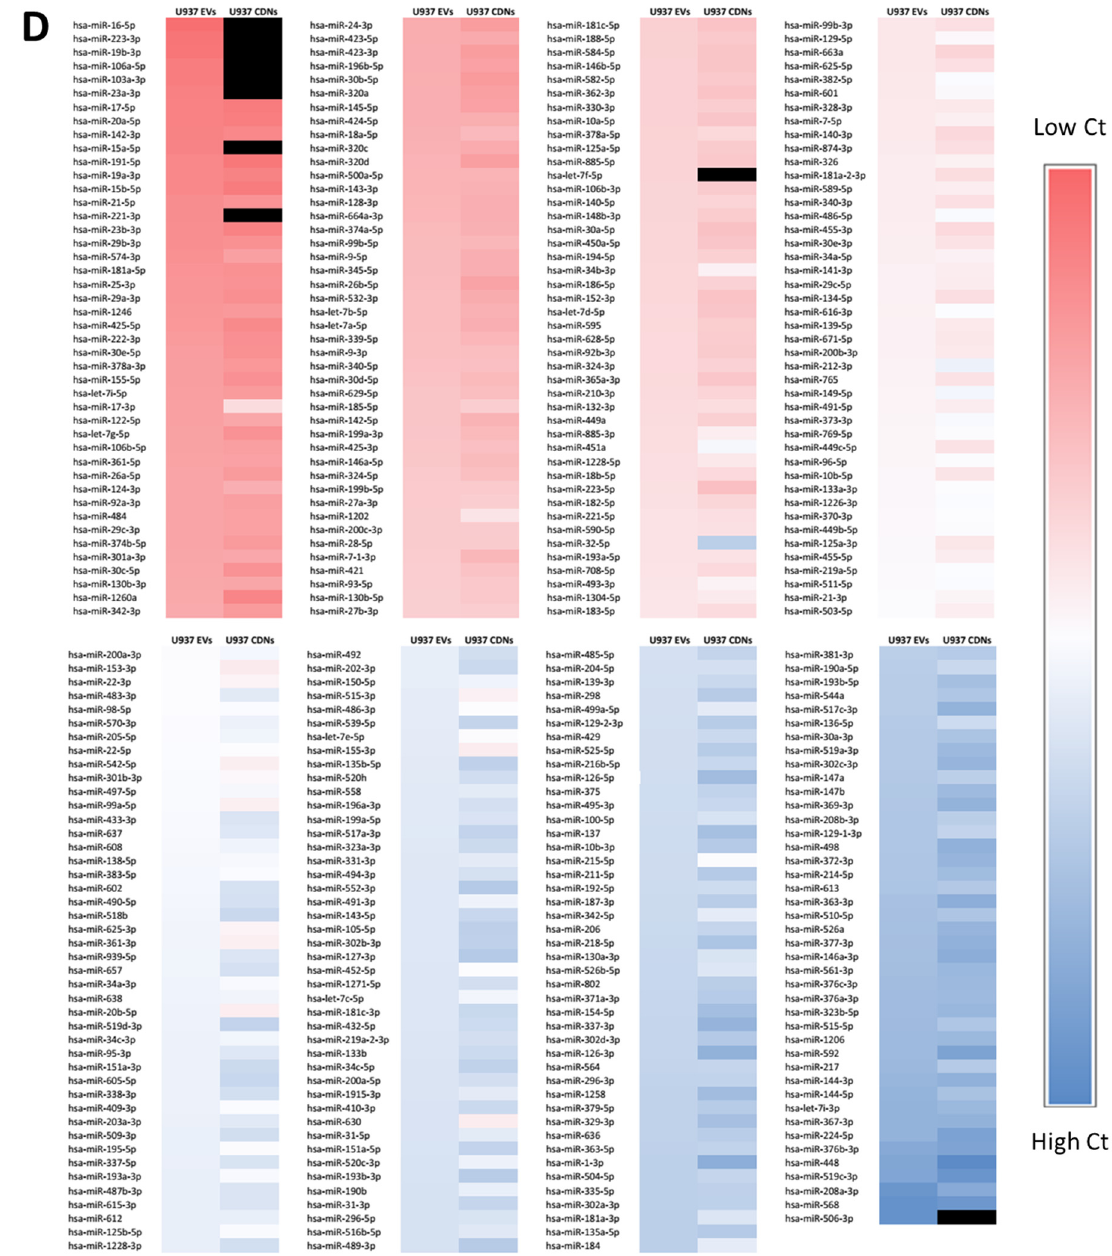
Figure 3. Comparison of the biochemical composition of U937 EVs and U937 CDNs. ( A ) Venn diagram comparing the protein profiles of U937 EVs and U937 CDNs. ( B ) Gene ontology of U937 EVs and U937 CDNs with respect to the cellular component. ( C ) Comparison of the lipid profiles of U937 EVs and U937 CDNs; n = 3. ( D ) Heat map comparing the miRNA profiles of (left) U937 EVs and (right) U937 CDNs; n = 2. Red indicates high abundance (low Ct values), blue indicates low abundance (high Ct values), and black indicates a lack of detection in at least one of the two replicates.